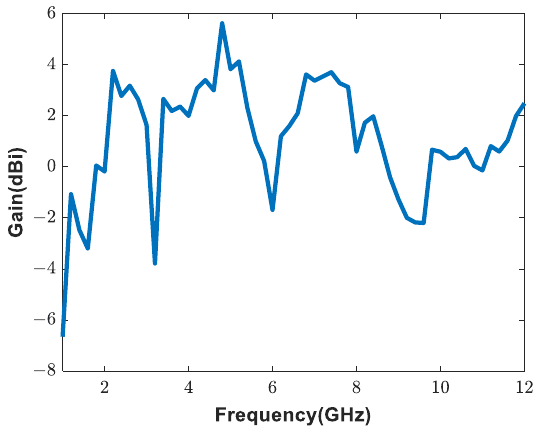
Figure 14. Gain of proposed antenna. Table 2. Parameter comparison with references.